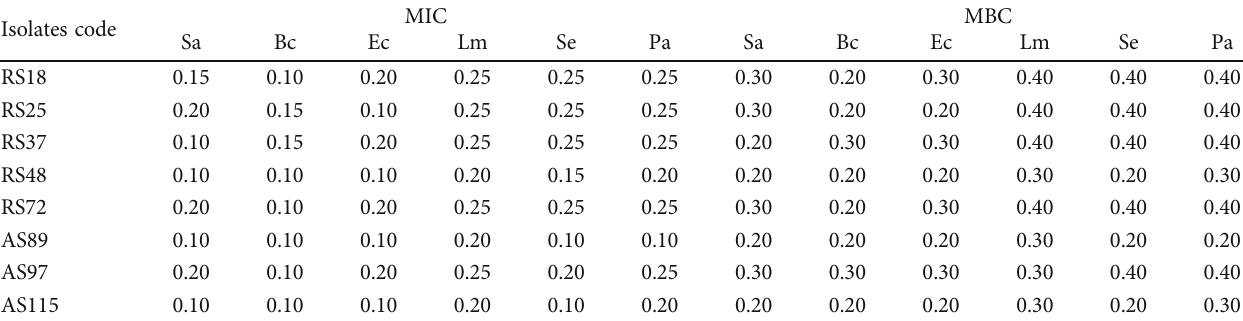
Table 7: The MIC and MBC of the isolates CFS in μ g/mL against foodborne bacterial strains. Isolates